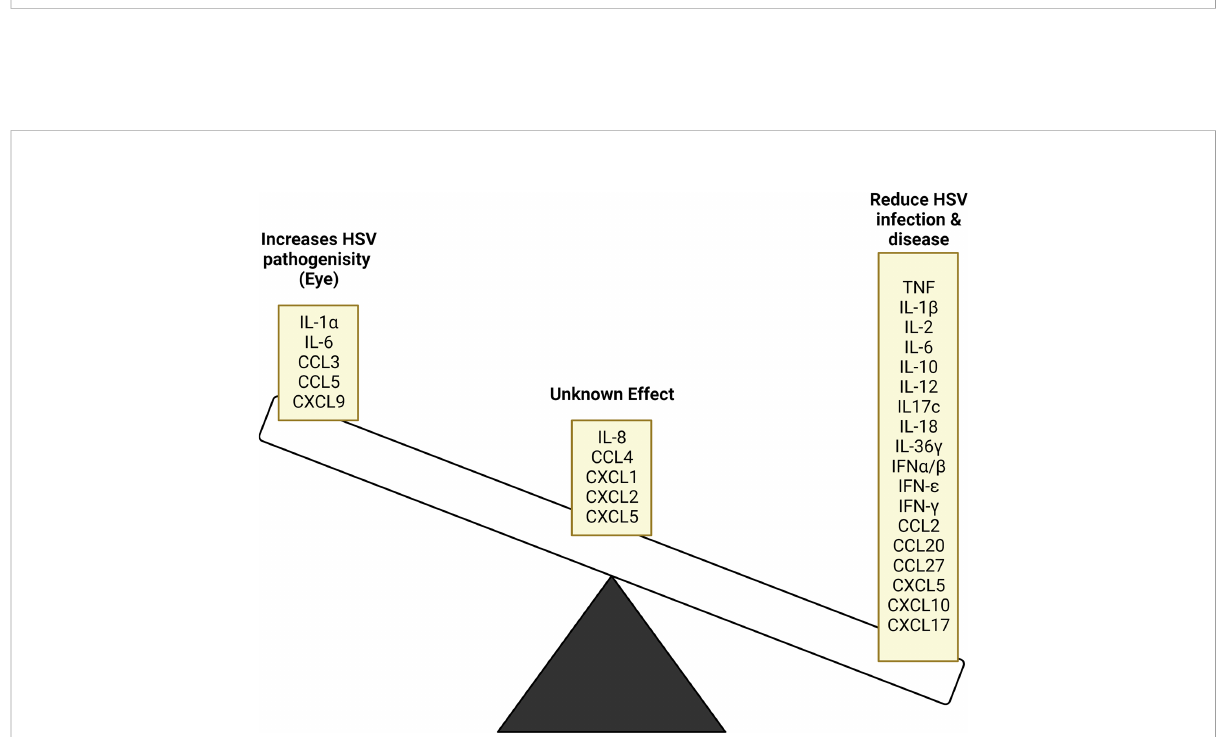
FIGURE 4 Cytokine and chemokine inhibitory and stimulatory effects on HSV replication and disease. HSV infection stimulates the production of various cytokine and chemokines, many of which act to supress viral replication. In some instances, these products have contradictory outcomes based on the tissue site being affected, while others require further study to determine their role. In ocular infection, the stimulated cytokines and chemokines released further HSV pathogenicity instead of resolving infection.